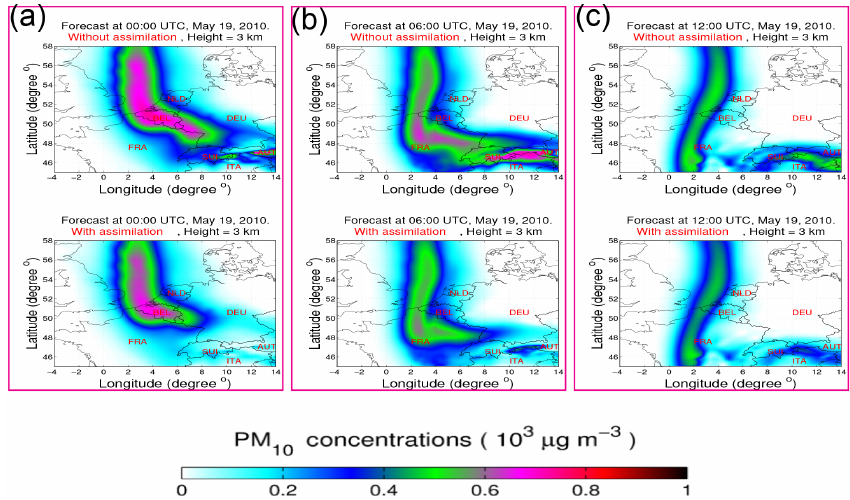
Figure 6. One-day forecast of PM 10 concentration with and without assimilation. A larger domain is chosen in this figure (compared to Figs. 2, 3, 4) to demonstrate the downwind change (with time) of the assimilation influenced area. (a) Forecast at 00:00UTC 19 May 2010. (b) Forecast at 06:00UTC 19 May 2010. (c) Forecast at 12:00UTC 19 May